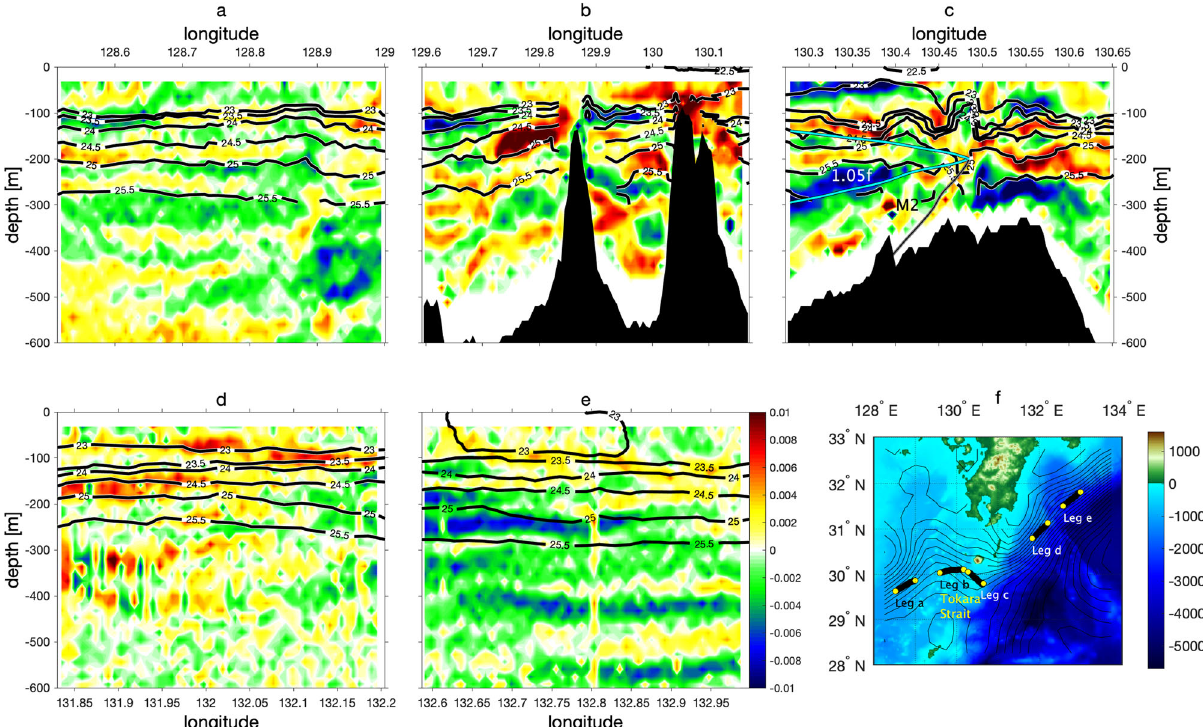
Fig. 1 Back-rotated shear (s – 1 ) measured by shipboard ADCP during the November 2017 cruise. Back-rotated shear (s – 1 ) for ( a ) Leg a, ( b ) Leg b, ( c ) Leg c, ( d ) Leg d, and ( e ) Leg e along the Kuroshio axis. Contours indicate isopycnals. The internal-wave ray paths computed assuming quiescent condition are shown in ( c ) for a near-inertial internal wave with frequency 1.05 f as cyan lines and M 2 internal tide as a black line. Seamount topography in the Tokara Strait is shown as black in ( b , c ). Location of the fi ve legs of the transect observations is shown in ( f ); contours are average sea surface height (m) during the observations (available from Copernicus Marine Environment Monitoring Service, http://marine.copernicus.eu) and color shading shows bottom topography (m). Topography data are ETOPO1 blended with the 500-m mesh data available from the Japan Oceanographic Data Center,